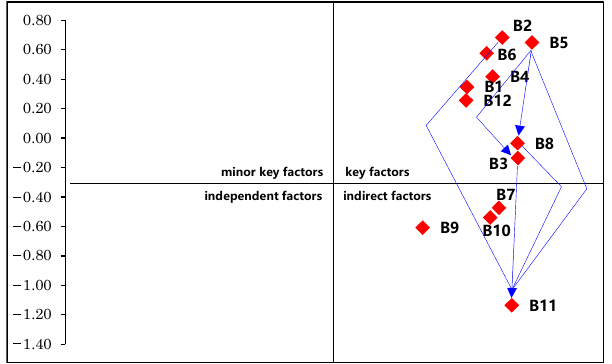
Figure 3. Prominence-relation map of the barriers to EDUC4 implementation.